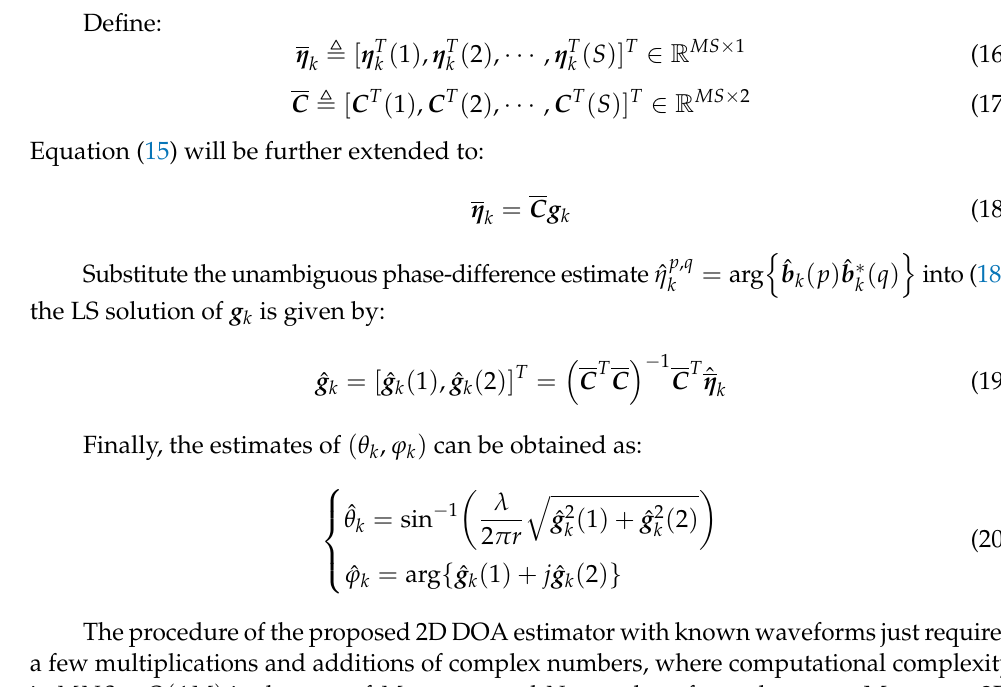
Figure 2. Baselines configuration of UCA. ( a ) M = 5, ( b ) M = 6, ( c ) M = 7, ( d ) M =